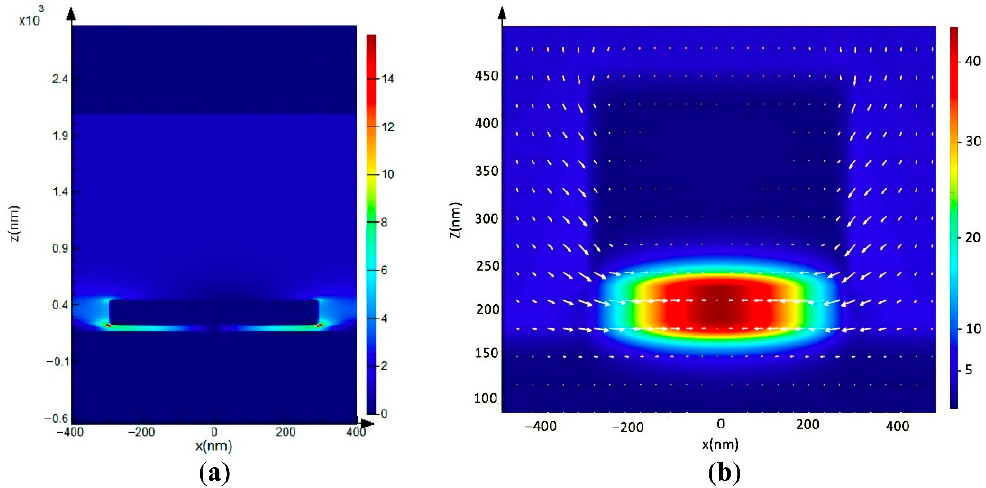
Figure 2. The electric field intensity distribution and the magnetic field intensity distribution at the resonant wavelength of the proposed optical switch structure: ( a ) when the VO 2 film is in the insulator phase, the electric field distribution at the cross-section is given along the z -axis, and ( b ) the magnetic field distribution at the resonant